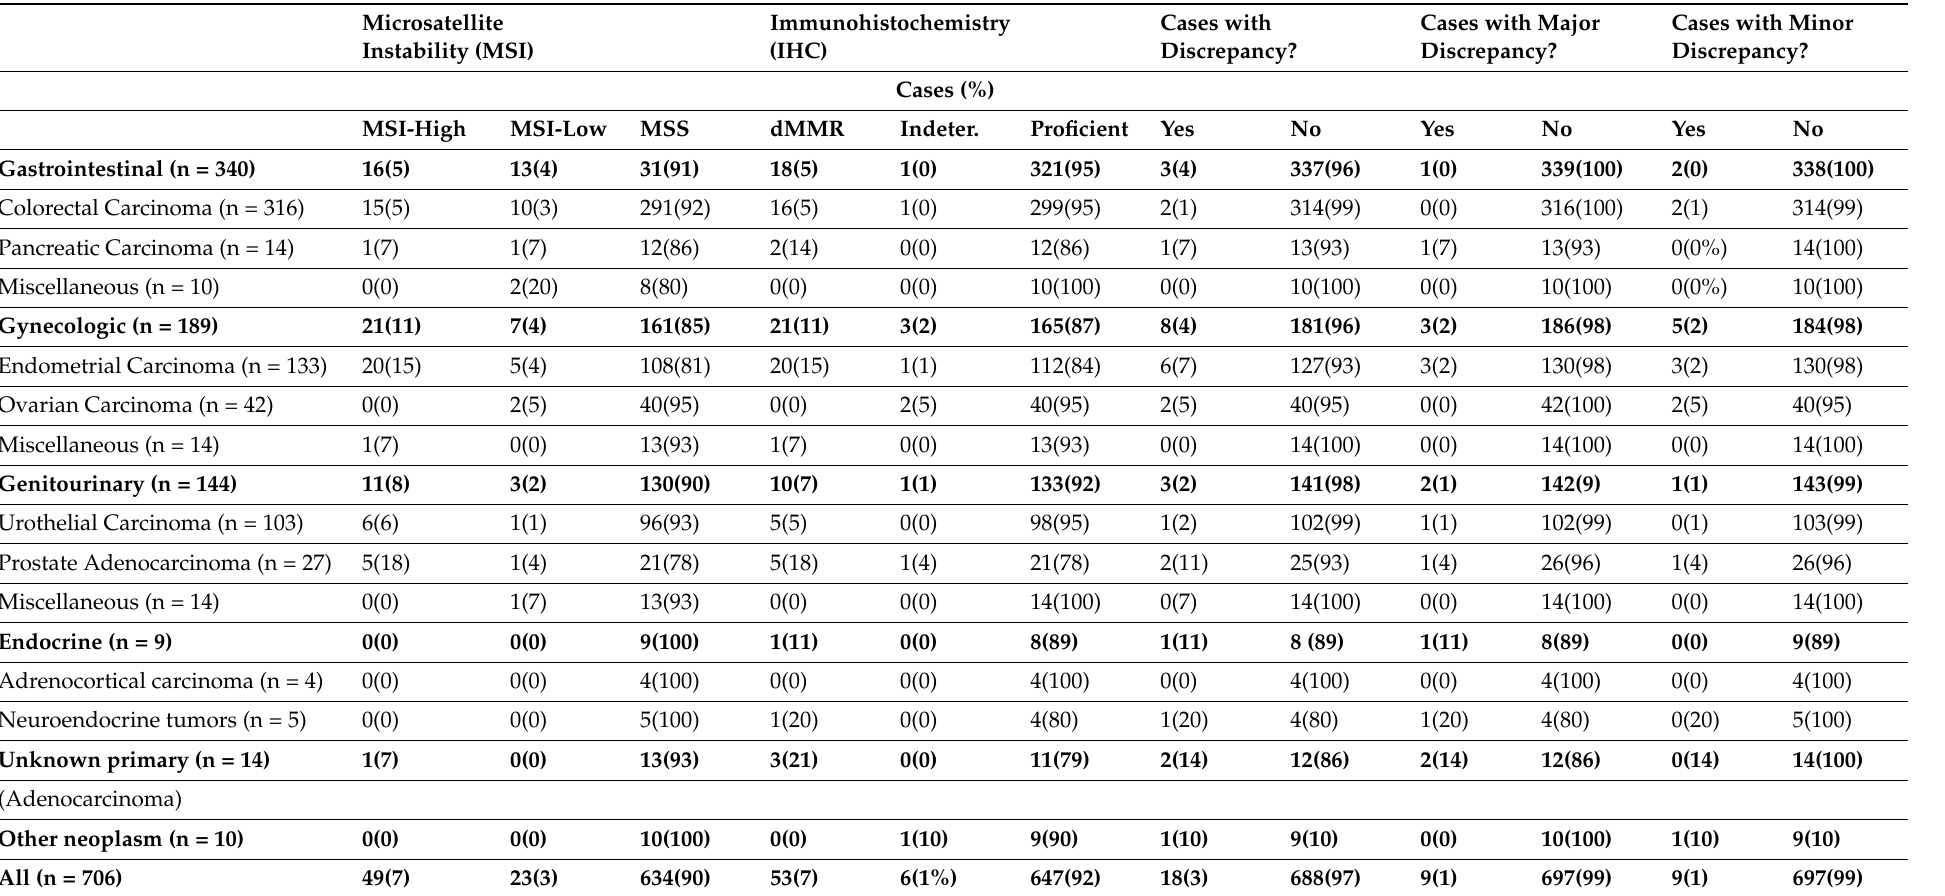
Table 1. Distribution of cases according to MSI and IHC statuses and tumor histology of concordant and discrepant IHC/MSI results based on tumor